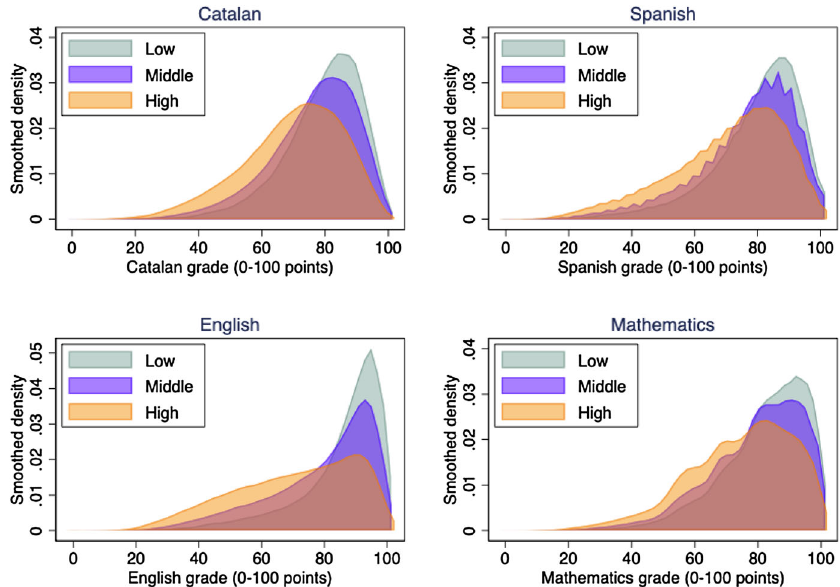
Fig. 3 Grade distributions by subject and school complexity level, pooled 2017–2019